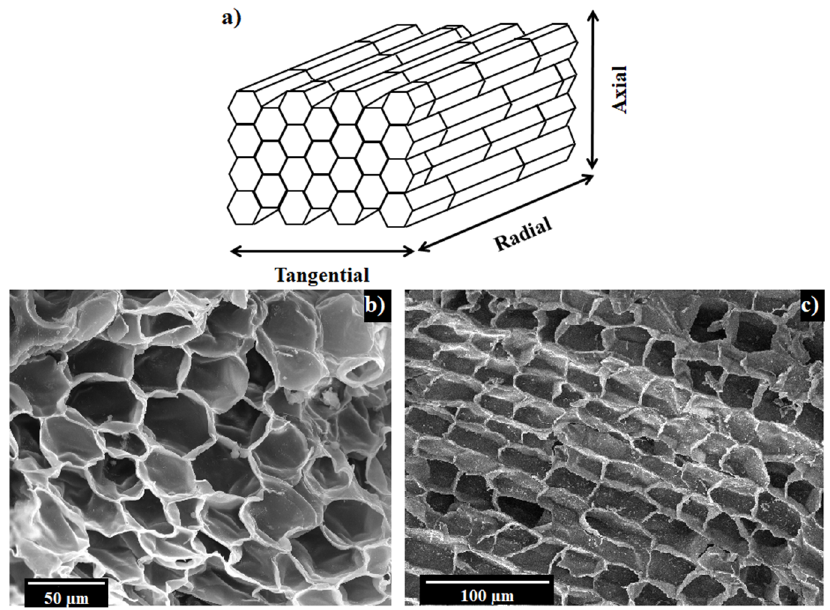
Figure 1. Schematic reconstruction of cork’s cellular microstructure ( a ), cork micrograph perpendicular to the radial direction ( b ), cork micrograph perpendicular to the tangential/axial direction ( c ).